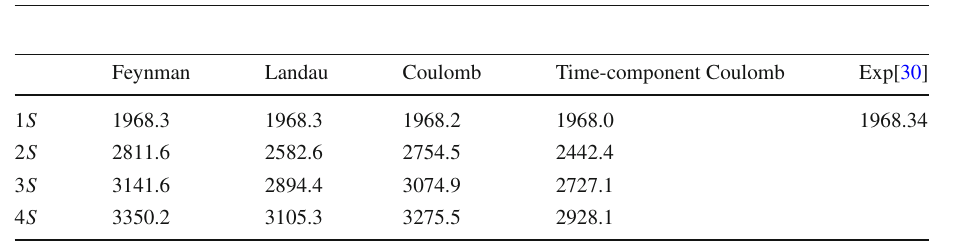
Table 3 Mass spectra of B ± ( nS ) in units of MeV using different gauge kernels